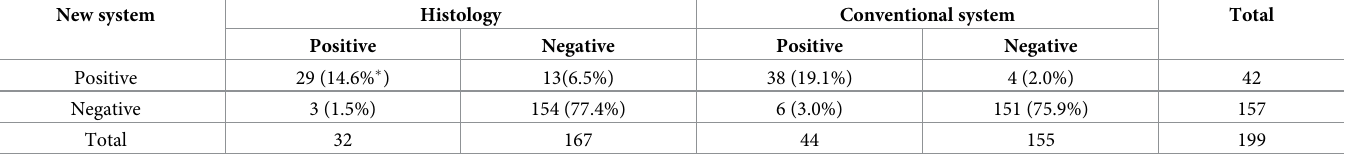
Table 3. Comparison of diagnostic performance between the new system and histopathology or the conventional system. New